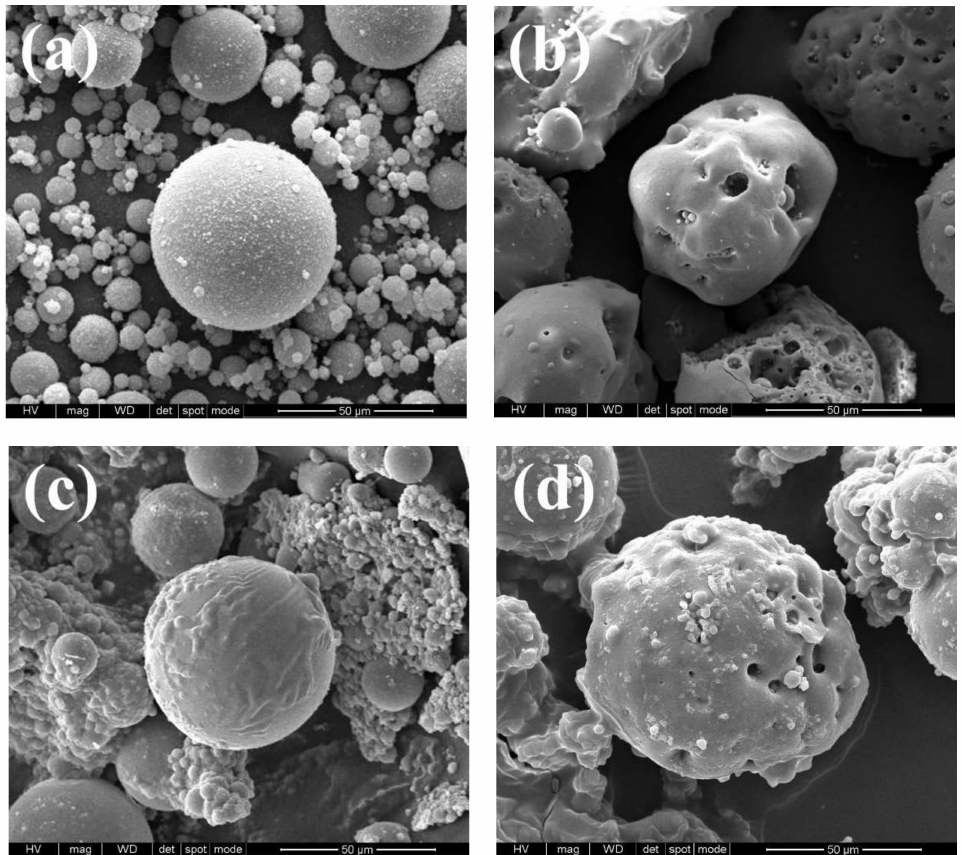
Figure 1. SEM images of ( a ) FA, ( b ) FAh, ( c ) LA/FA and ( d )